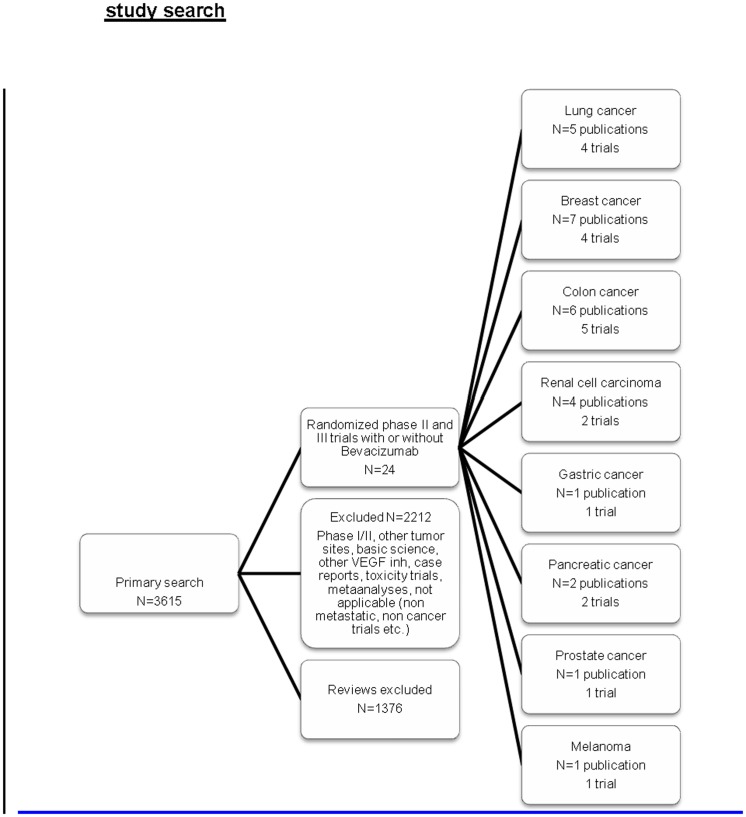
Trial selection.